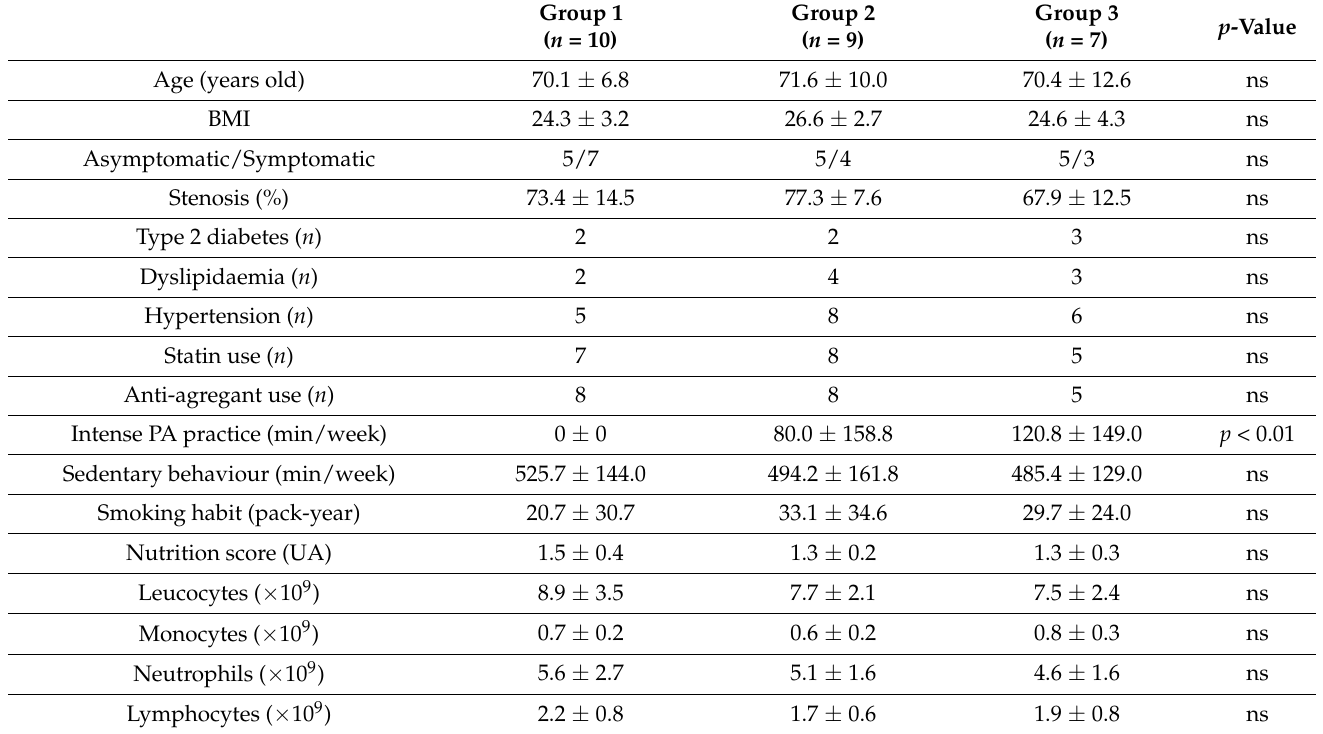
Table 2. Physical activity level groups risk factors, comorbidities, and complete blood count. BMI: body mass index; PA: physical activity and ns: non-significant. Group